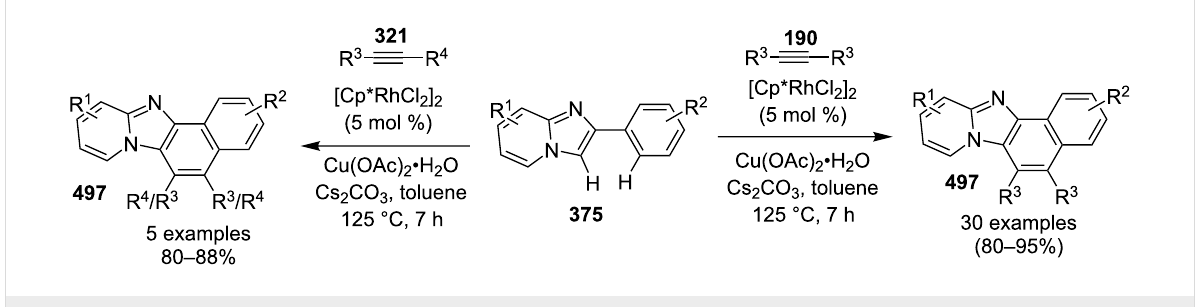
Scheme 174: Rh(III)-mediated oxidative coupling reaction.